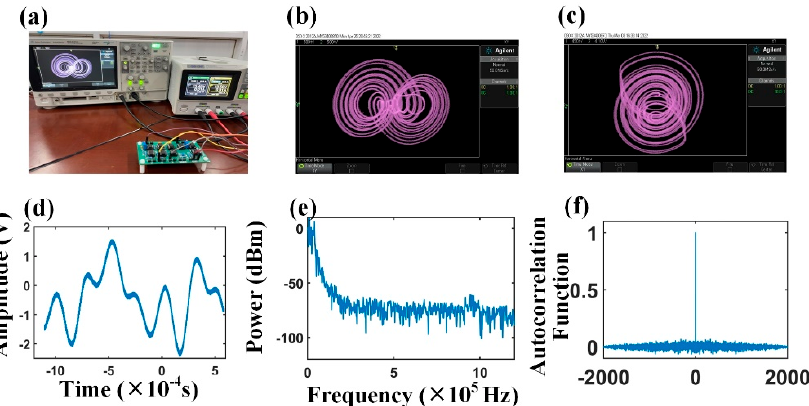
Figure 4. ( a ) Physical equipment of the analog circuit, ( b ) x – y phase trajectory, ( c ) y – z phase trajectory, ( d ) temporal waveform, ( e ) spectrum, and ( f )